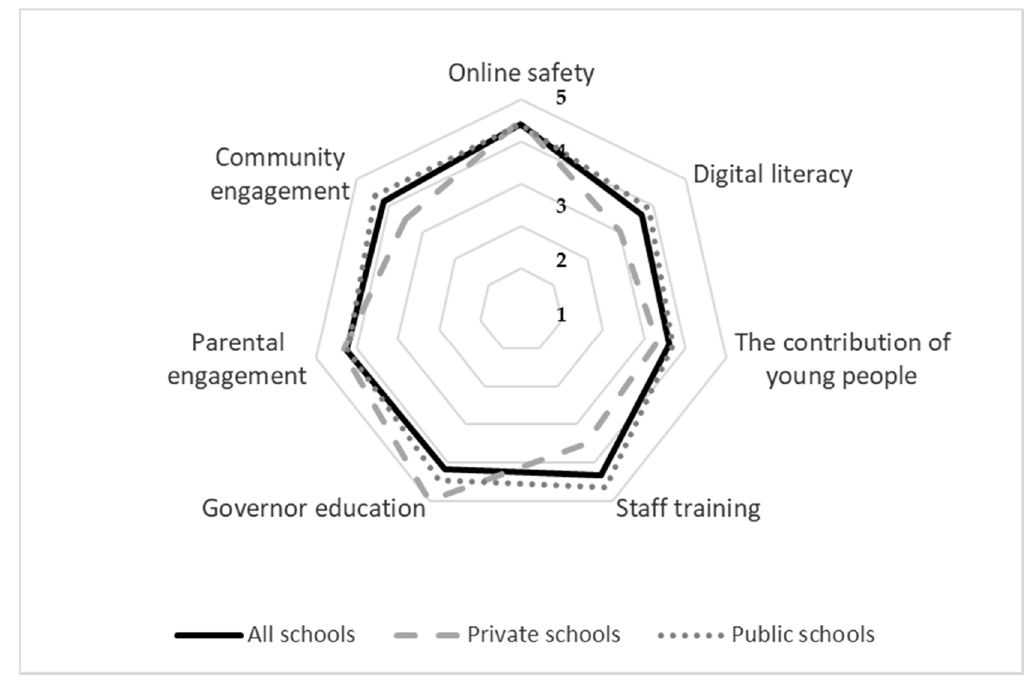
Figure 3. Strands 1 to 5 of Element C.